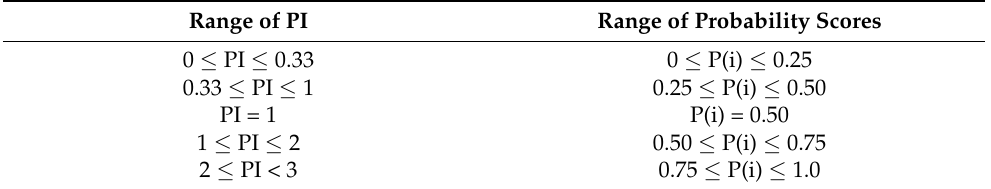
Table 2. Range of PI and probability scores. Range of PI Range of Probability Scores